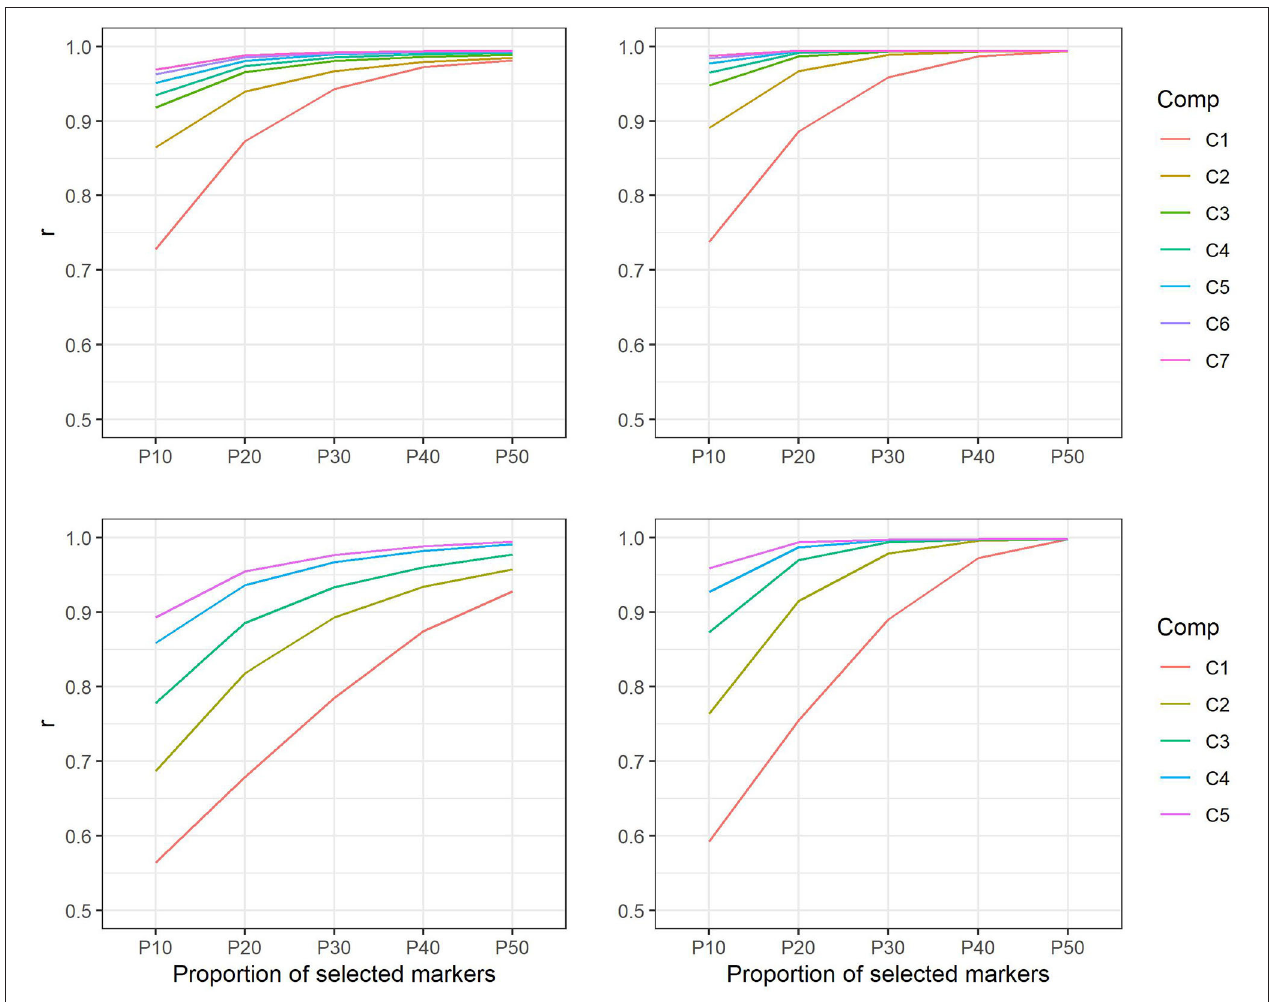
FIGURE 3 | Correlations between marker-based relationship matrices using markers selected on the basis of positive loadings only and marker-based relationship matrix using all markers in E. nitens (upper left) and in P. radiata (bottom left) populations and correlations between marker-based relationship matrices using markers selected on the basis of both positive and negative loadings and marker-based relationship matrix using all markers in E. nitens (upper right) and in P. radiata (bottom right) populations. Each line represent scenario for different number of latent variables considered in marker selection (e.g., C1—only the first latent variable is considered, C2—only the first two latent variables are considered,